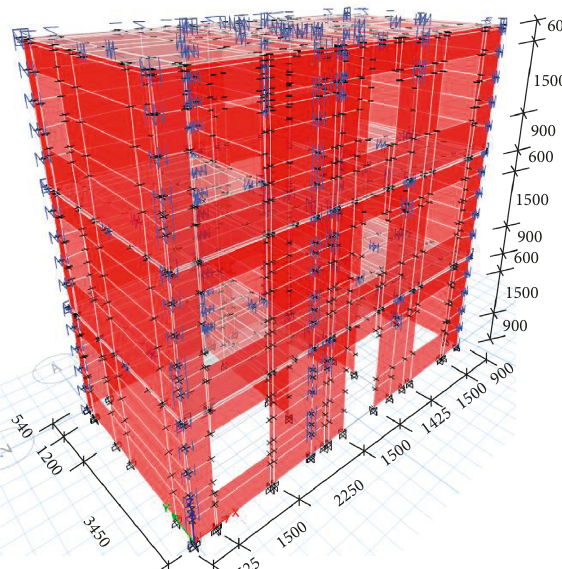
Figure 30: Numerical model of the three-story precast wall panel structure (unit: mm).